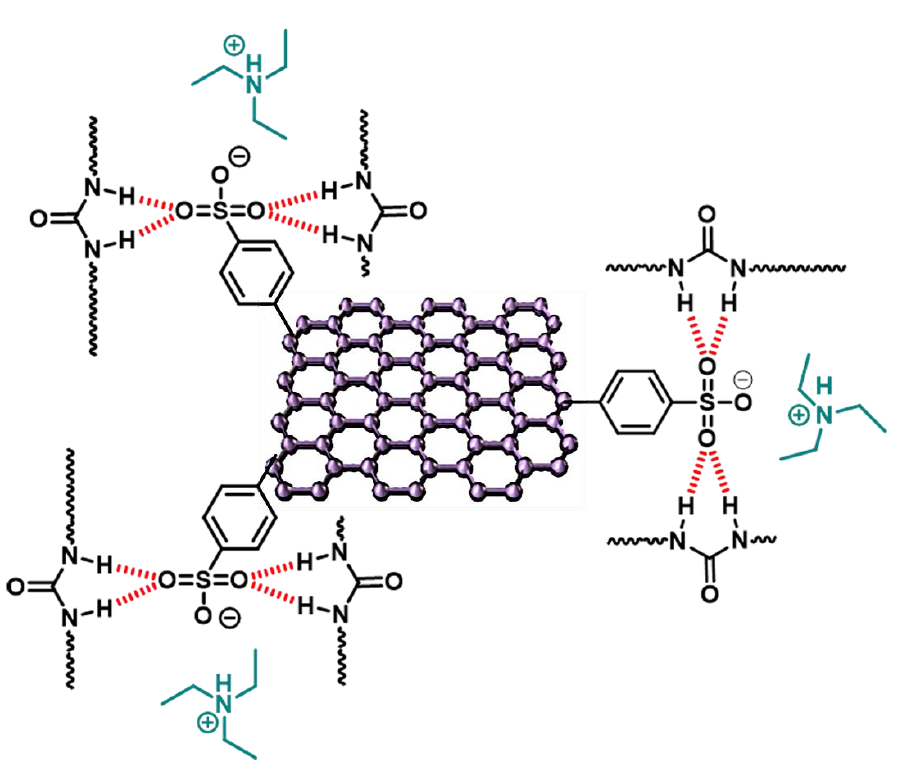
Figure 5. The dissociation mechanism of sulfonic acid groups on SG nanosheets in WPUA emulsion.